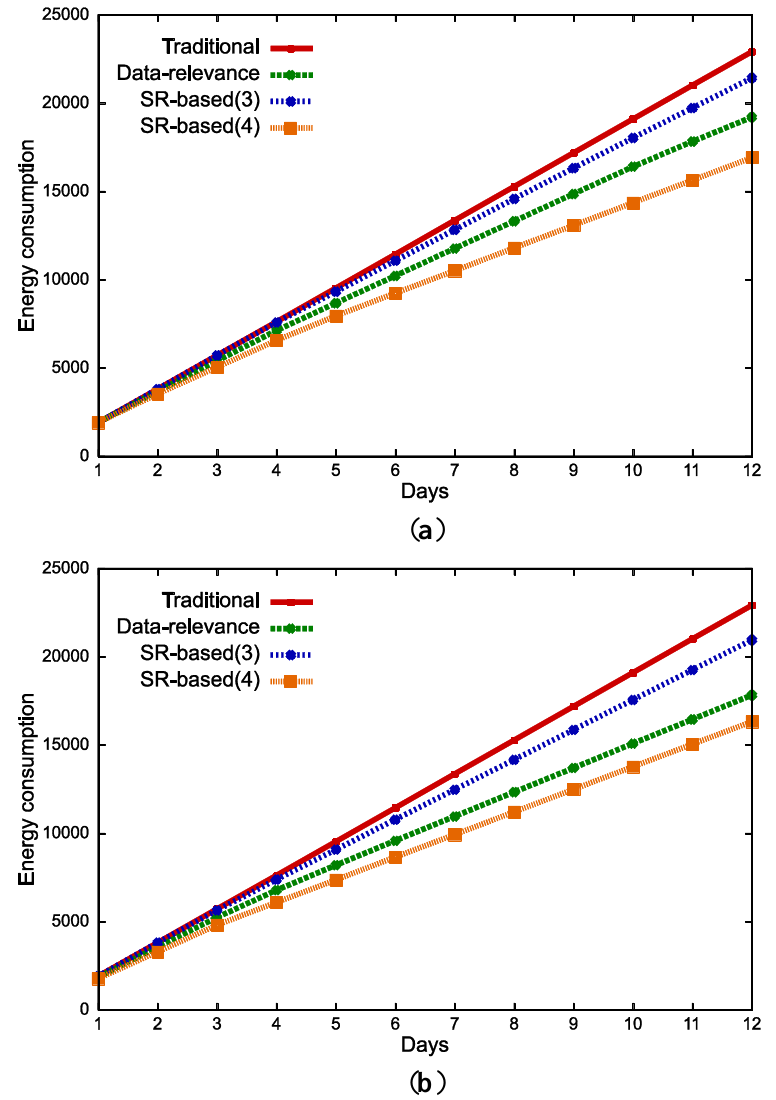
Figure 9. Energy consumption for Scenario 2. ( a ) e e = 0.8 and e 2